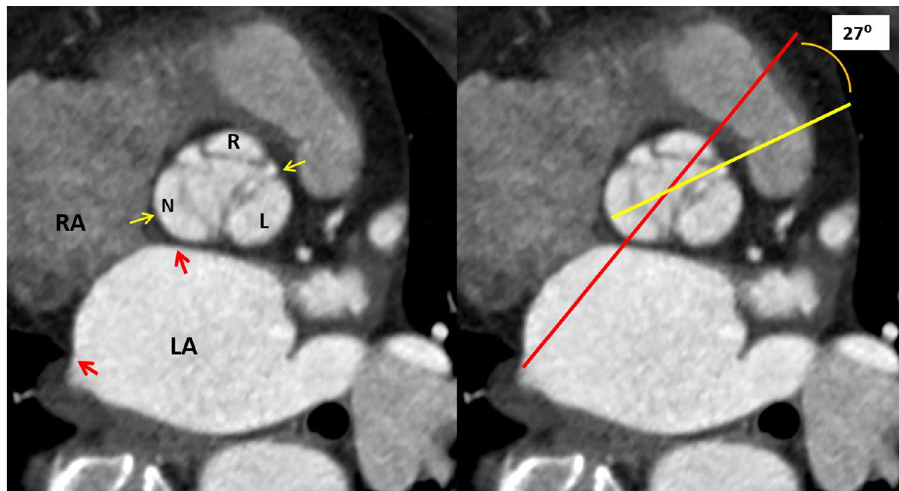
Figure 2. Method of aortic root rotation angle measurement between the red line (the plane of the interatrial septum) and the yellow line (connecting the middle of the non-coronary sinus and the anterior commissure) using true short-axis image of the aortic valve.